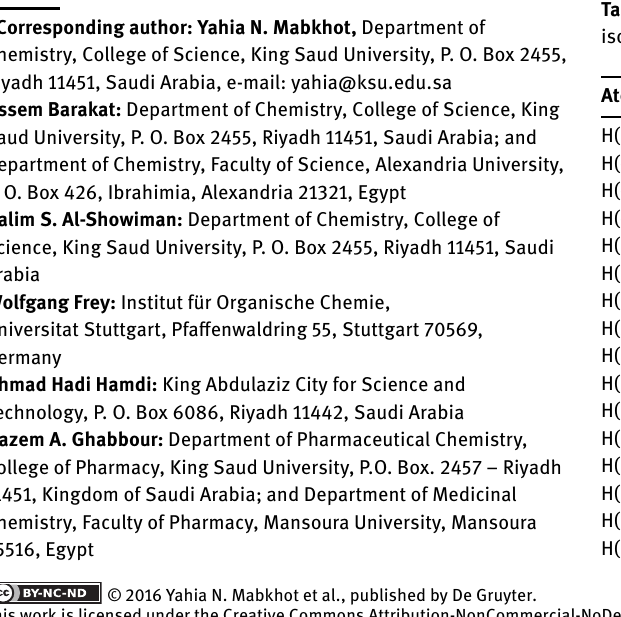
Table 2: Fractional atomic coordinates and isotropic or